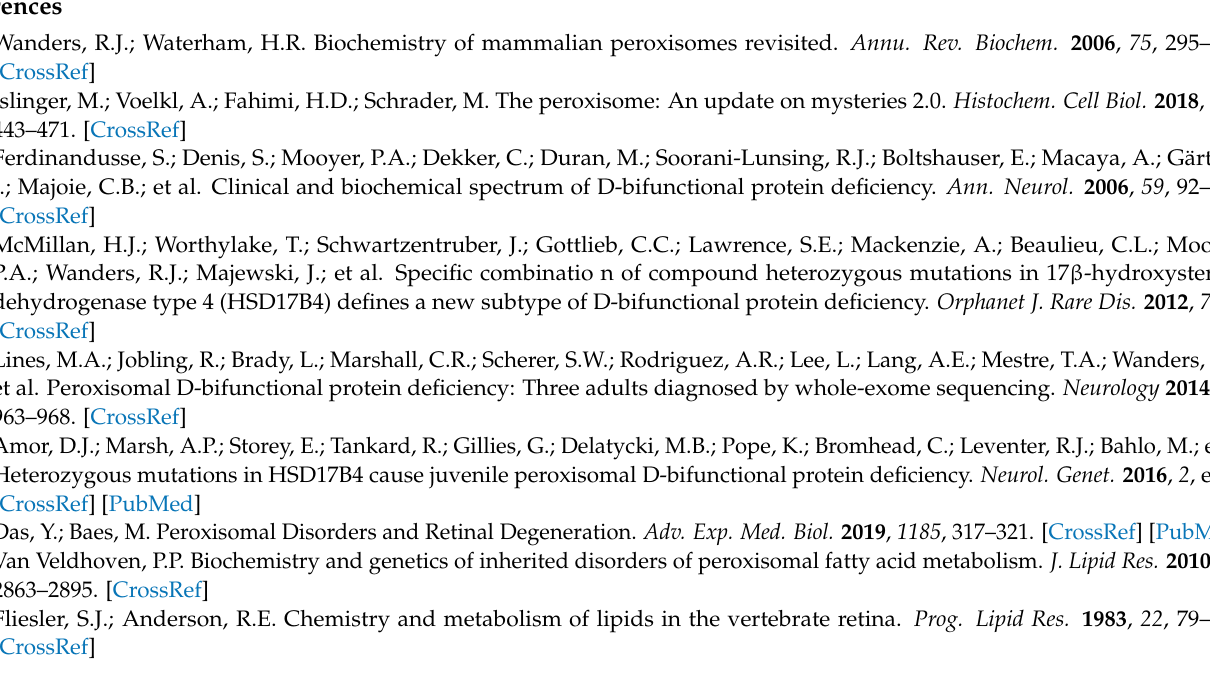
Crx-Mfp2 − / − mice. Figure S5: Lipid droplets accumulate in the rod bipolar cells of Crx-Mfp2 − / − mice, Figure S6: Additional TEM images of the photoreceptor ribbon synapse of 6-month-old Crx-Mfp2 − / − mice, Figure S7: No increase in oxidative stress in the neural retina of Crx-Mfp2 − / − mice, Figure S8: Full blot of the confirmation of Crx-Pex5 knockout, Figure S9: PKC α and VGLUT1 double staining in Crx-Pex5 − / − mice reveals loss of bipolar cells and ectopic sprouting into the